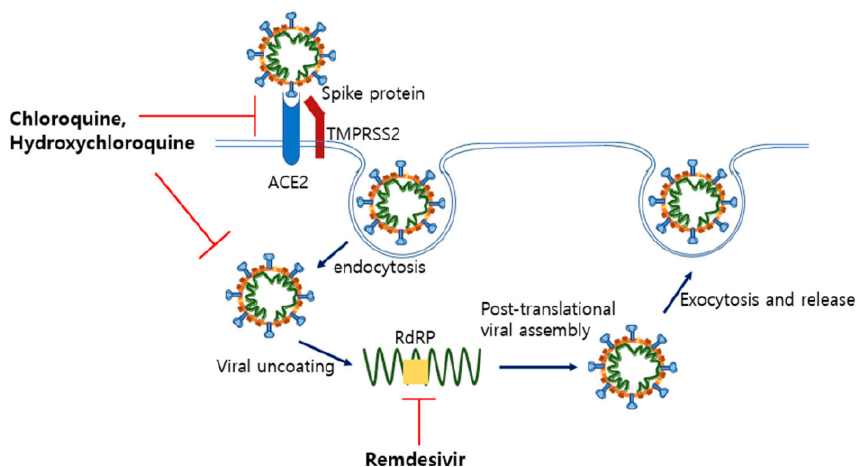
Figure 6. Mechanism of antiviral drugs inhibition of SARS-CoV-2. Chloroquine and hydroxy- chloroquine raise endosomal pH and block viral uncoating. Additionally, they seem to interrupt glycosylation of the spike protein, which is expected to block SARS-CoV-2 recognition of ACE2. However, recent clinical trials did not show any benefits, i.e., decreased mortality or short recovery time. Thus, the FDA recommended clinicians not use chloroquine or hydroxychloroquine for patients. Remdesivir is a nucleotide analogue that blocks the activity of RNA-dependent RNA polymerase (RdRP). Additionally, clinical trials showed that the use of remdesivir shortened the recovery time of COVID-19